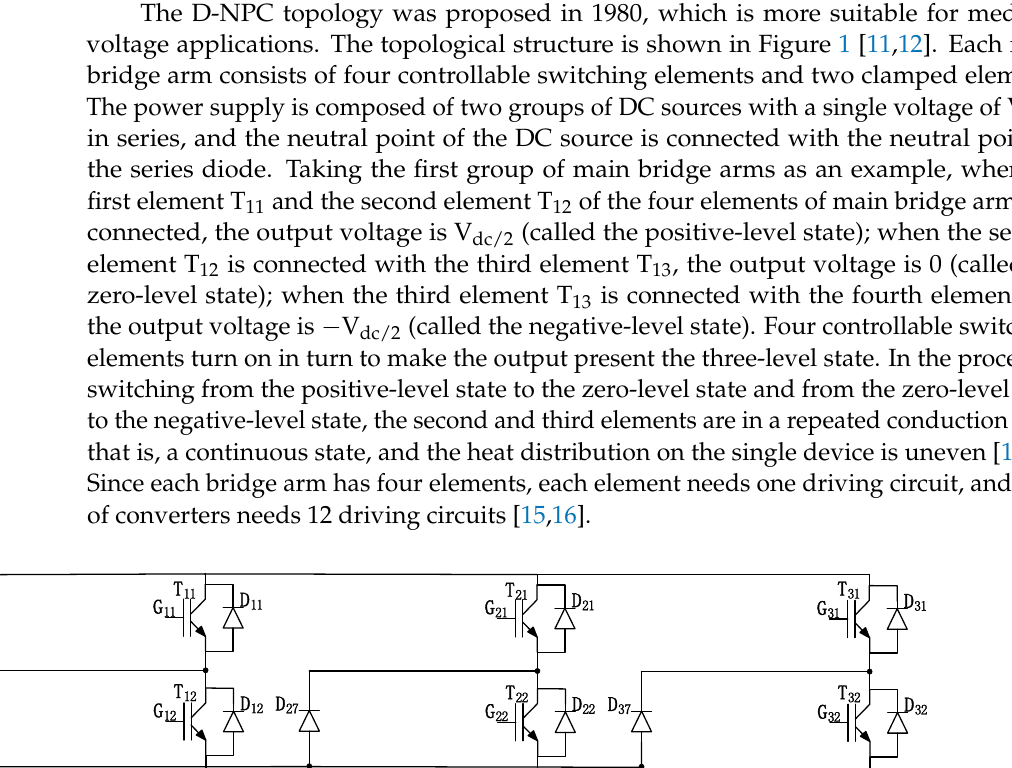
Table 1. The comparison of four traditional topologies.